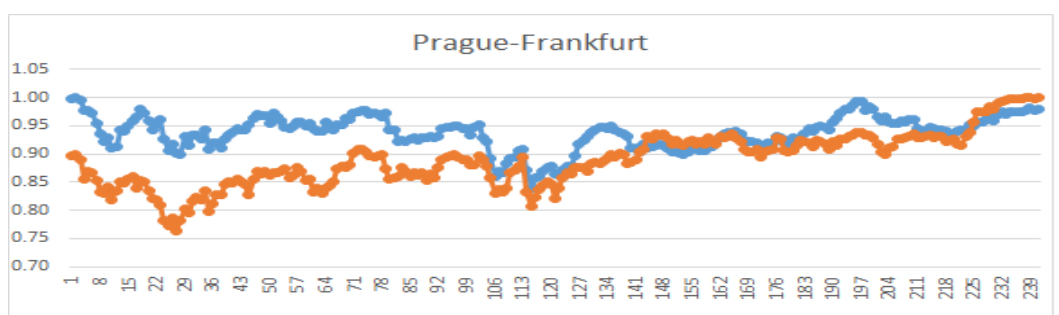
Figure 4. Comparison of graphs of normalized prices for Prague and Paris; S ( Prague,Paris ) = 0.9.